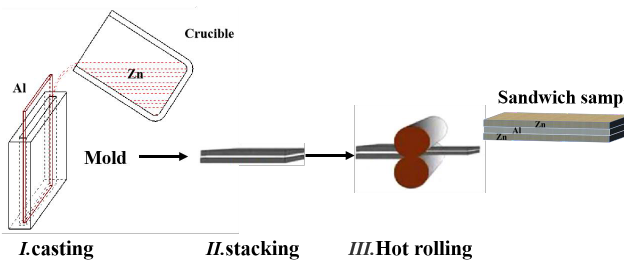
Figure 1. Process flow diagram of Al/Zn laminated composite plate.